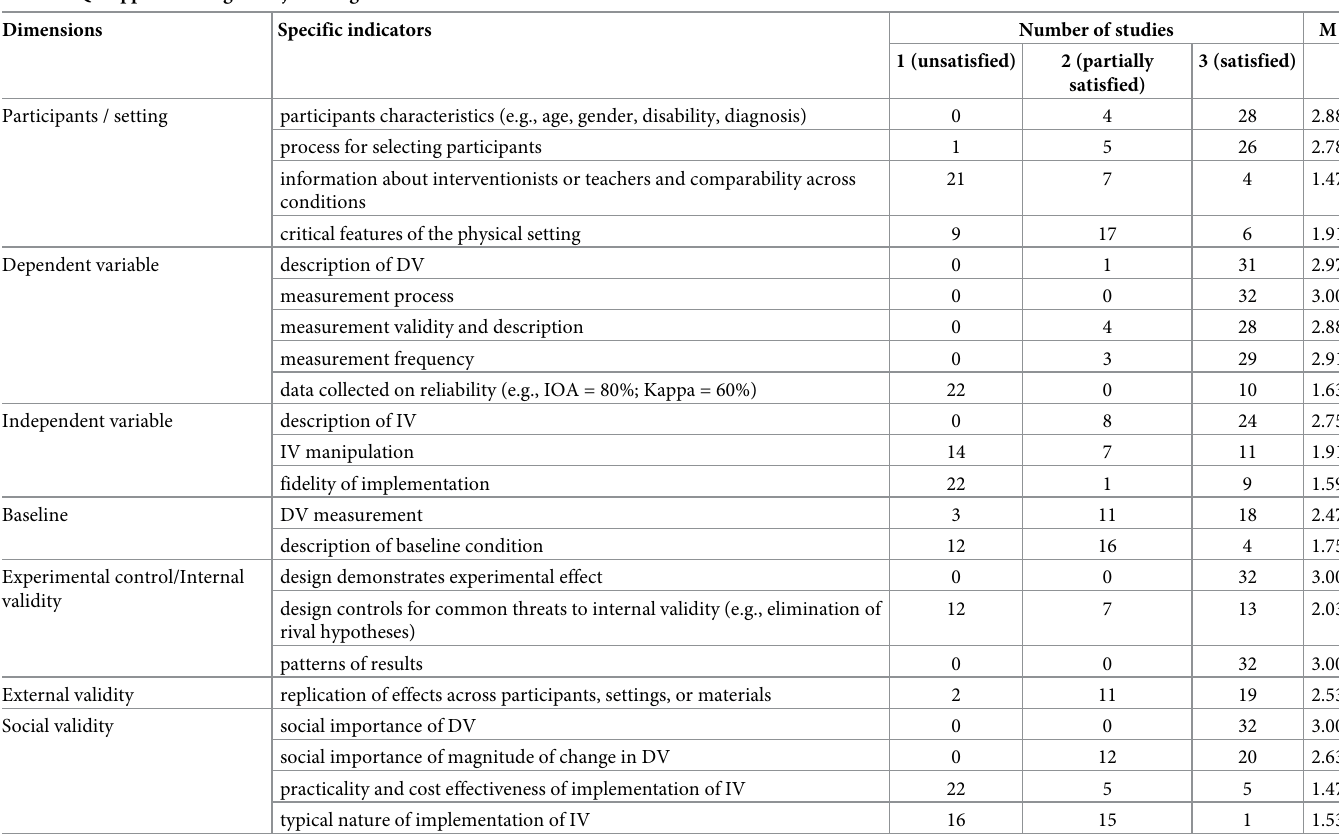
Table 7. QIs applied to single-subject design studies.